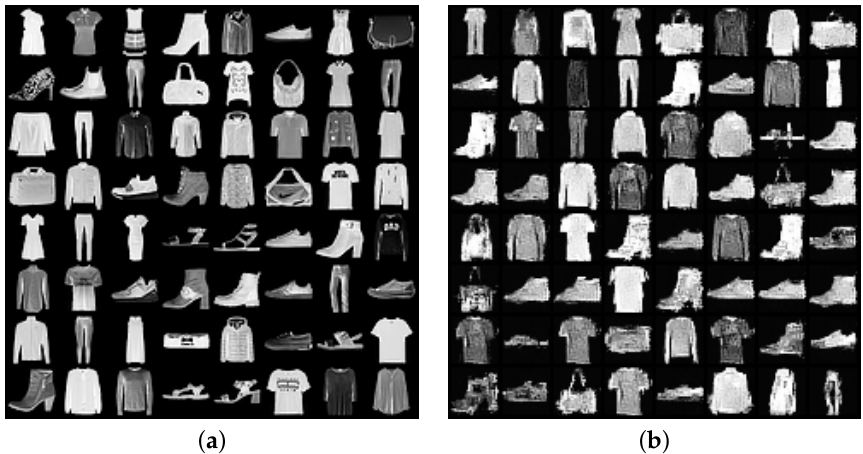
Figure 2. Real and synthetic samples on Fashion-MNIST. ( a ) Real; ( b )